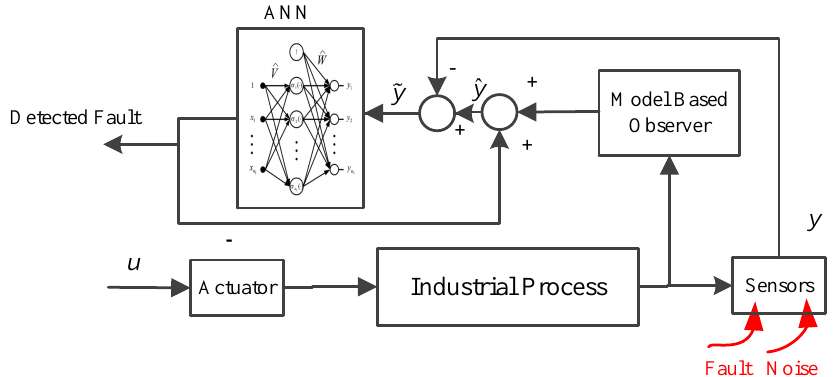
Figure 12. General structure of the combined ANN and model-based